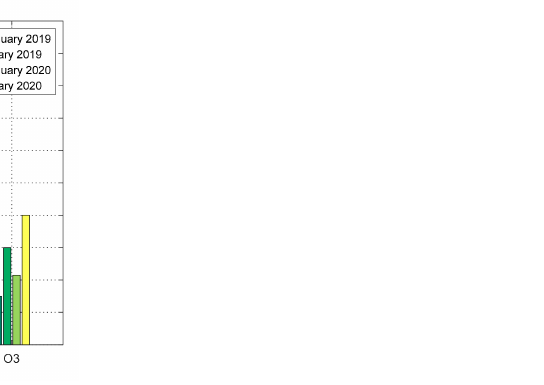
Figure 4. The average values of AQI and six main pollution concentrations in different periods of time. Table 2. The average values of AQI and six main pollution concentrations in different periods of time. Time AQI